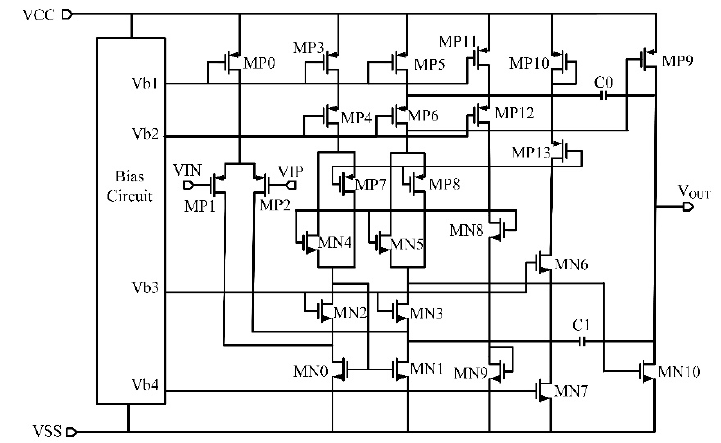
Figure 3. Schematic of the complete two-stage op amp circuit.